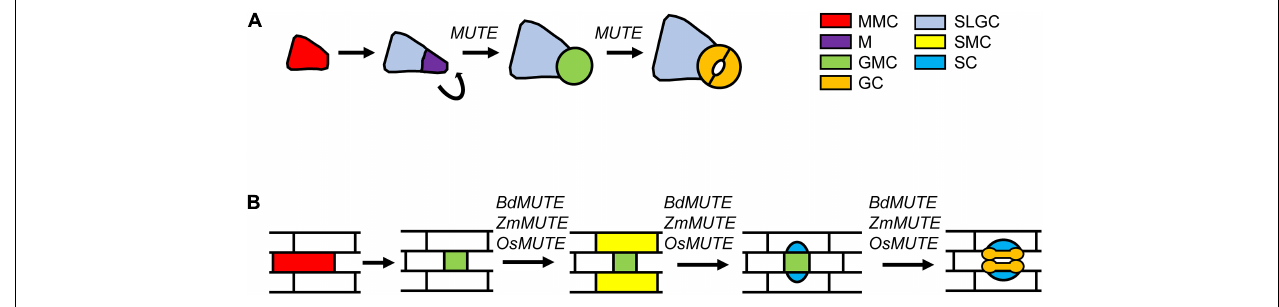
FIGURE 1 | Steps regulated by MUTE and MUTE orthologs of grasses during stomatal development. (A) Stomatal development in Arabidopsis initiates when a protodermal cells acquires MMC identity. The MMC undergoes an asymmetric division that generates a small M and a larger SLGC. Ms usually reiterate their asymmetric divisions in an inward spiral. Ms activity stop when they assume GMC identity. GMCs divide symmetrically to produce the two kidney-shaped GCs. MUTE controls the transition from M to GMC, and the GMC division to produce a pair of kidney-shaped cells. (B) In grasses, stomatal development starts with an asymmetric division from an MMC that, in contrast with Arabidopsis, directly produces the GMC. Then, cells from files on either side of the GMC adopt SMC identity. SMCs divide asymmetrically to produce the two SCs making contact with the GMC. Once GMC is flanked by the SCs, it undergoes a symmetric division producing the two dumbbell-shaped GCs. Grass MUTE genes, in addition to control SMC identity and SCs formation, they also regulate GMC fate and GC morphogenesis. GC, guard cell; GMC, guard mother cell; M, meristemoid; MMC, meristemoid mother cell; SC subsidiary cell; SLGC, stomatal lineage ground cell; SMC, subsidiary mother cell.